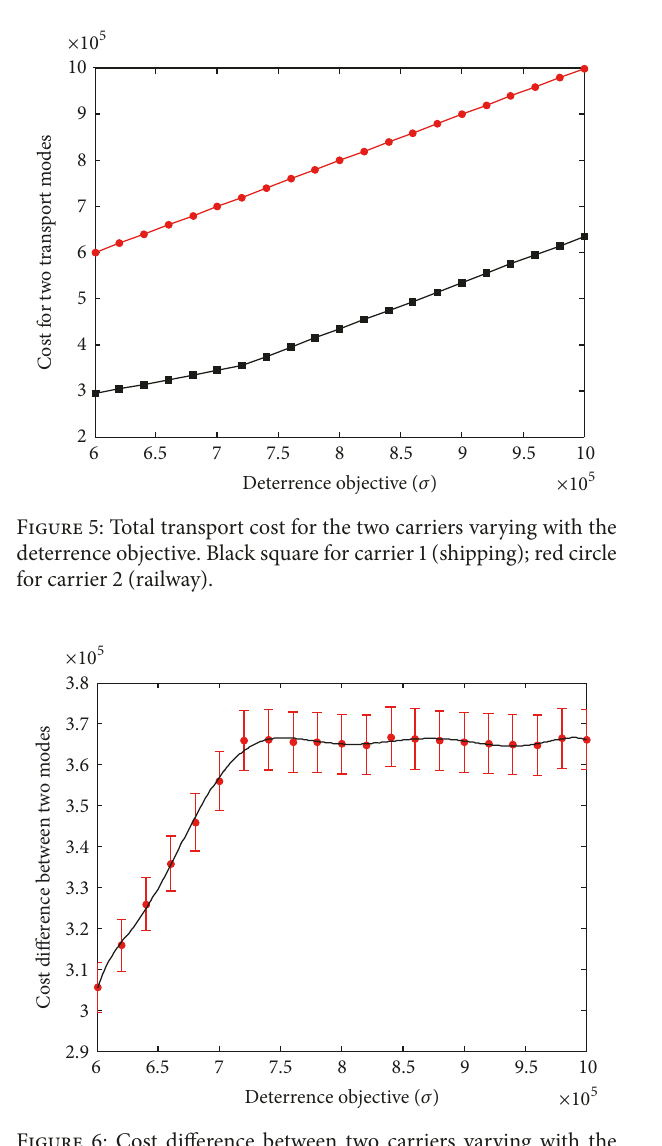
Figure 6: Cost difference between two carriers varying with the settled deterrence objective.